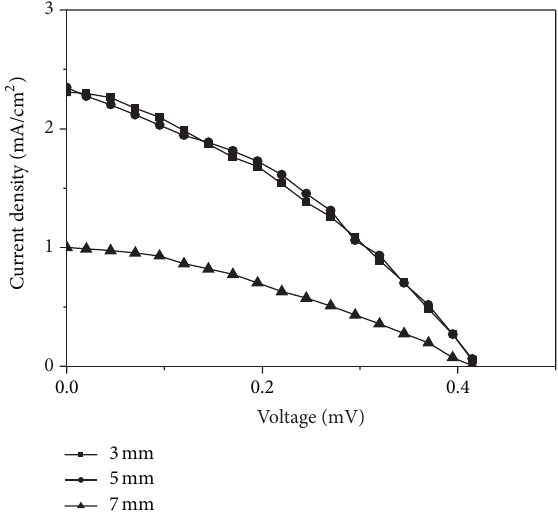
Figure 8: Photovoltaic curves ( J-V ) of the prepared 3D DSSC made by a graphite counter electrode at different cell heights.